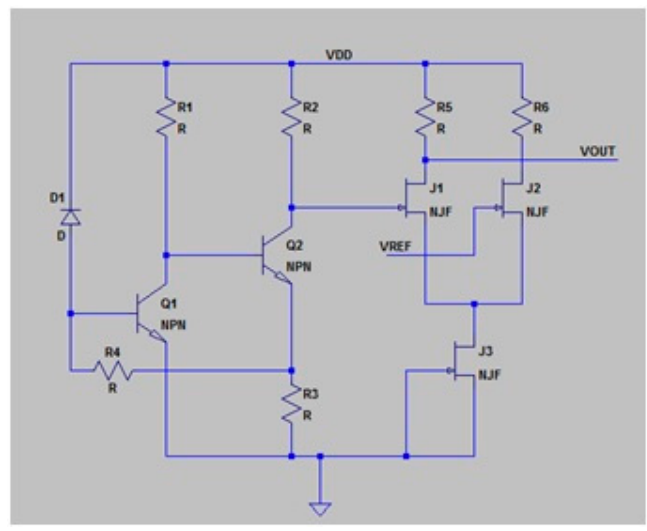
Figure 6. Microscopic view of the integrated optoelectronic circuit, showing the grating couplers, Ge photodiodes, and transimpedance amplifier fabricated by the IME process.